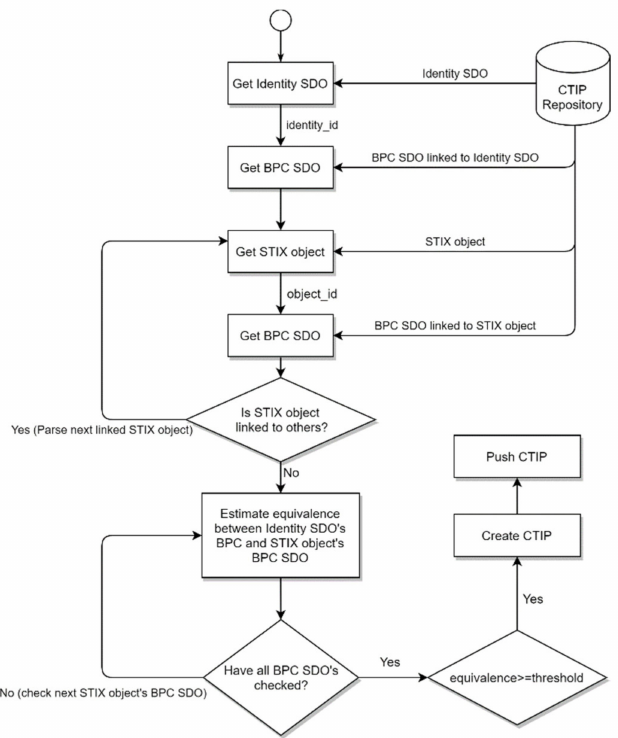
Figure 6. Flowchart diagram representing the workflow of the proposed filtering